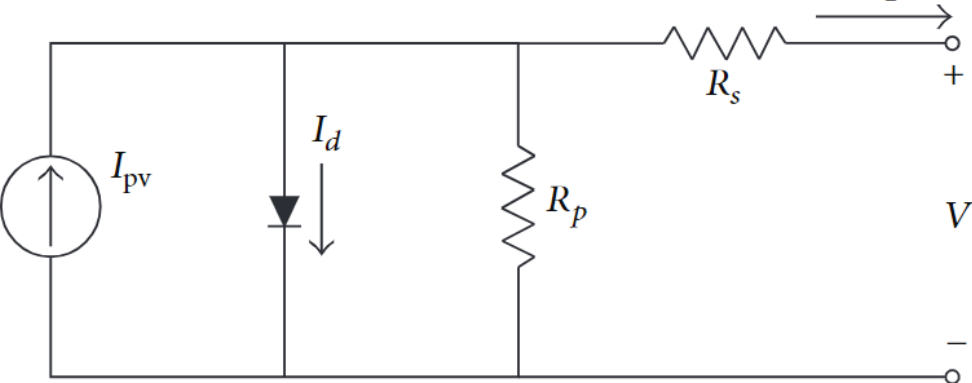
Figure 10. Circuit diagram of the